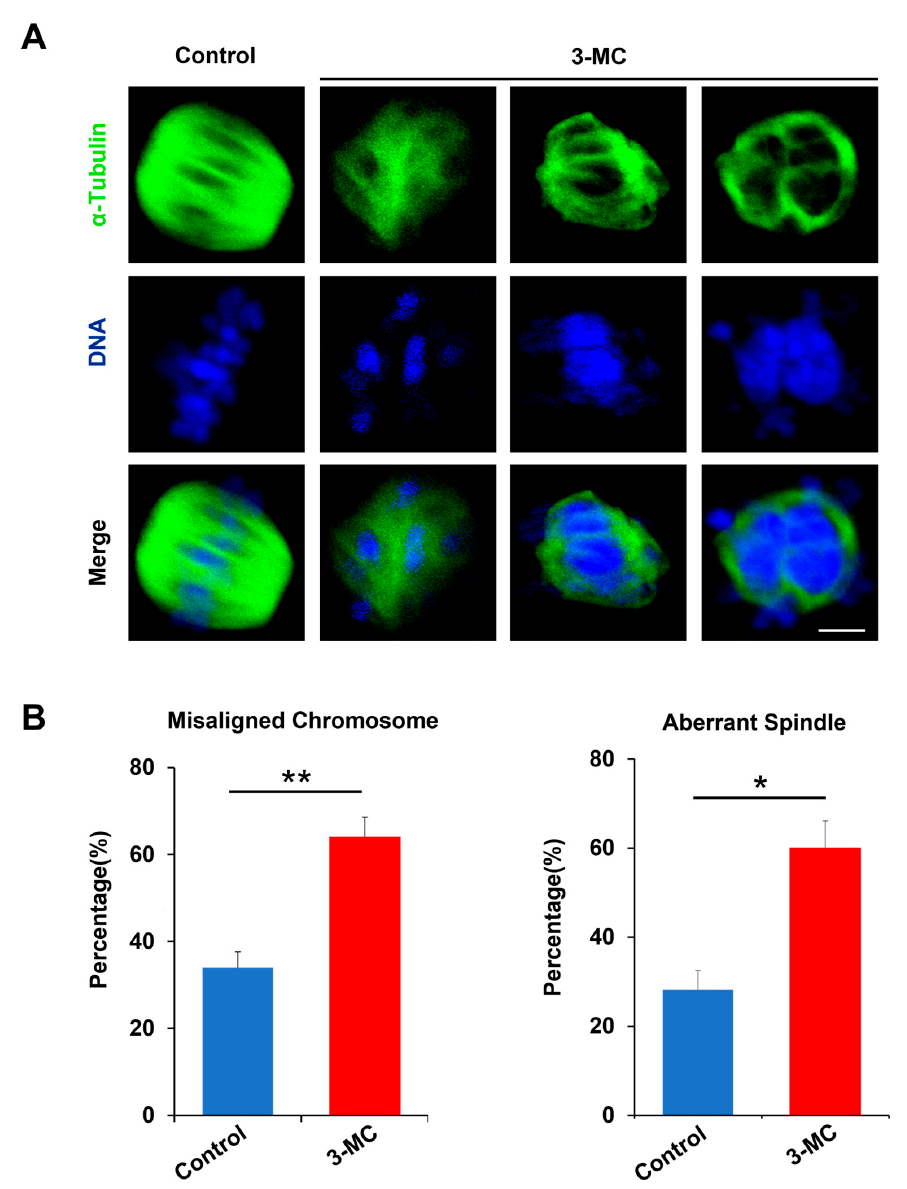
Figure 2. Effects of 3-MC exposure on the chromosome alignment and spindle assembly in porcine oocytes. ( A ) Representative images of chromosome and spindle morphologies in control and 100 µ M 3-MC treatment oocytes were stained with anti- α -Tubulin antibody (green) to visualize the spindles and were counterstained with 4 (cid:48) ,6-diamiolino-2-pnenylindole (bule) to visualize the chromosomes, scale bar 3.5 µ M; ( B ) the rate of misaligned chromosomes and aberrant spindles was recorded in each group. All the data were shown as mean ± S.E.M of at least three independent experiments. ** p < 0.01, * p <